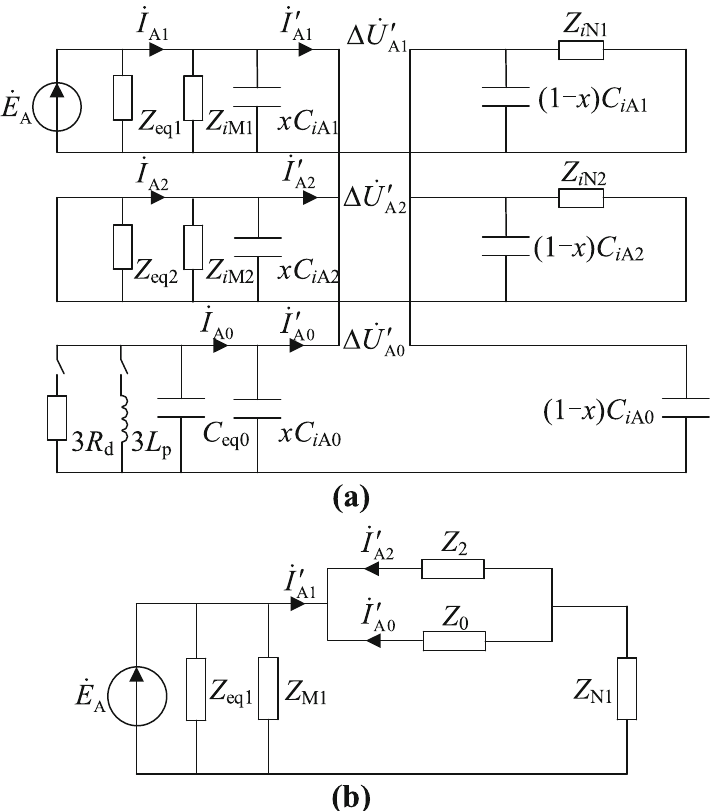
Fig. 2 Composite sequence network of single-phase break fault (a) Composite sequence network (b) Equivalent